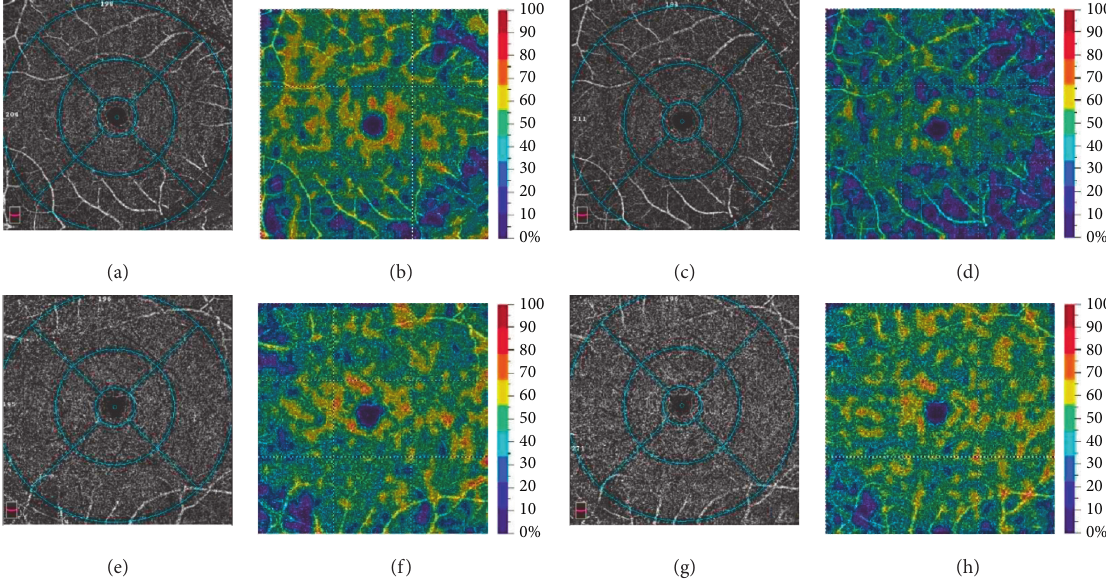
Figure 1: (a)–(d) Retinal angiogram and color-coded map of the right eye of the healthy participant at DCP before and after induction of hyperoxia. Vessel density at DCP significantly decreased in the parafoveal region after hyperoxic challenge. (e)–(h) Retinal angiogram and color-coded map of the left eye of the patient with diabetes mellitus without retinopathy at DCP before and after induction of hyperoxia. Vessel density at DCP showed minimal change in the parafoveal region after hyperoxic challenge. DCP, deep capillary